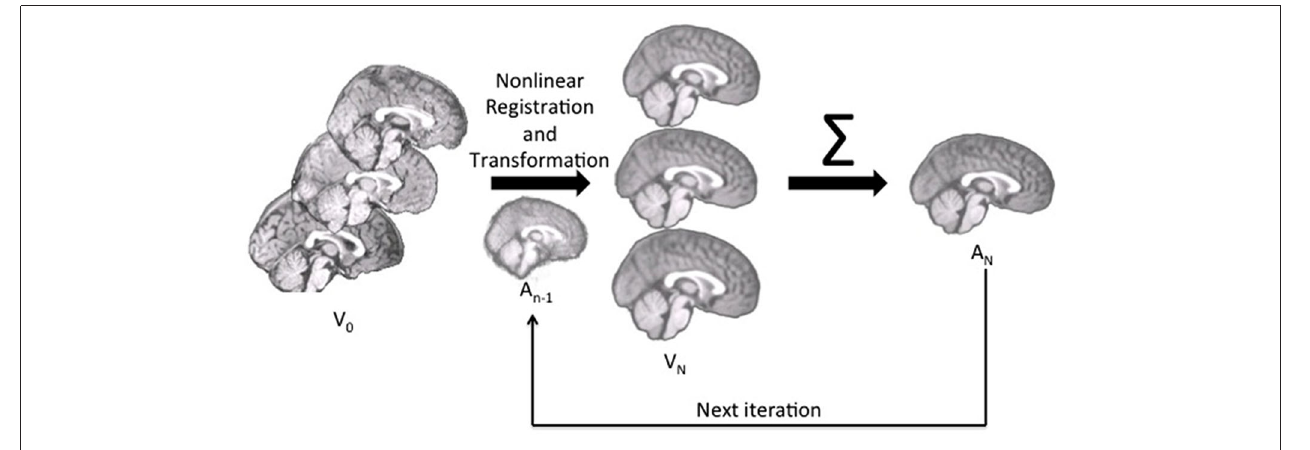
target, to which each participant brain was nonlinearly registered and transformed (V n ). With each iteration, the participant brains were nonlinearly registered to the new average (A n − 1 ), transformed and then re-averaged to create a new, relatively more precise average (A n ) for the next